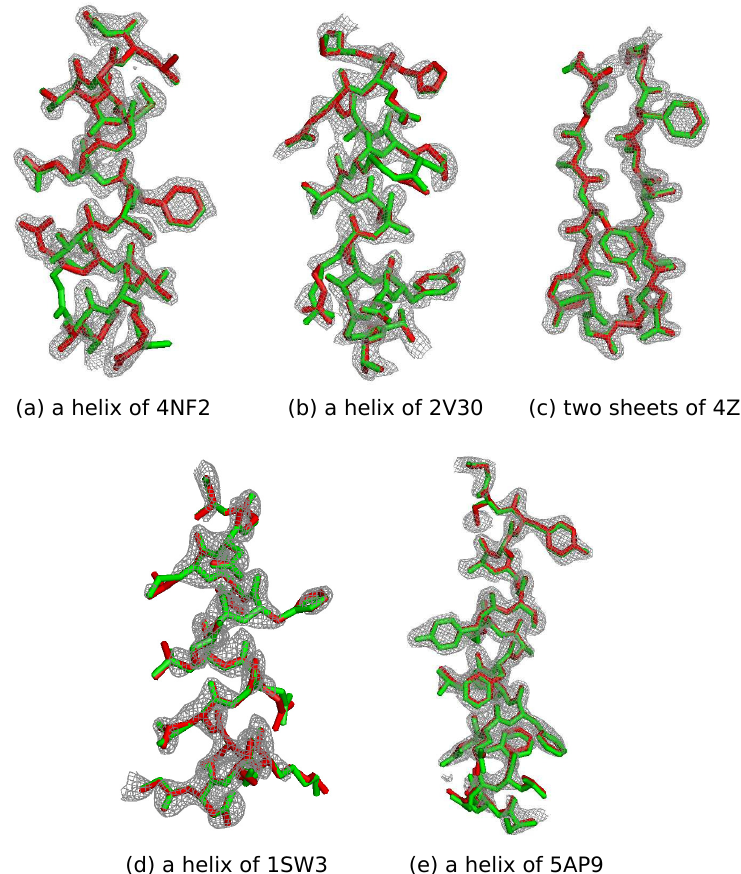
Figure 16. The calculated density map (gray mesh) and the reconstructed model (green sticks) with the PDB deposited model (red sticks) superimposed. The model was rebuilt with ARP/wARP